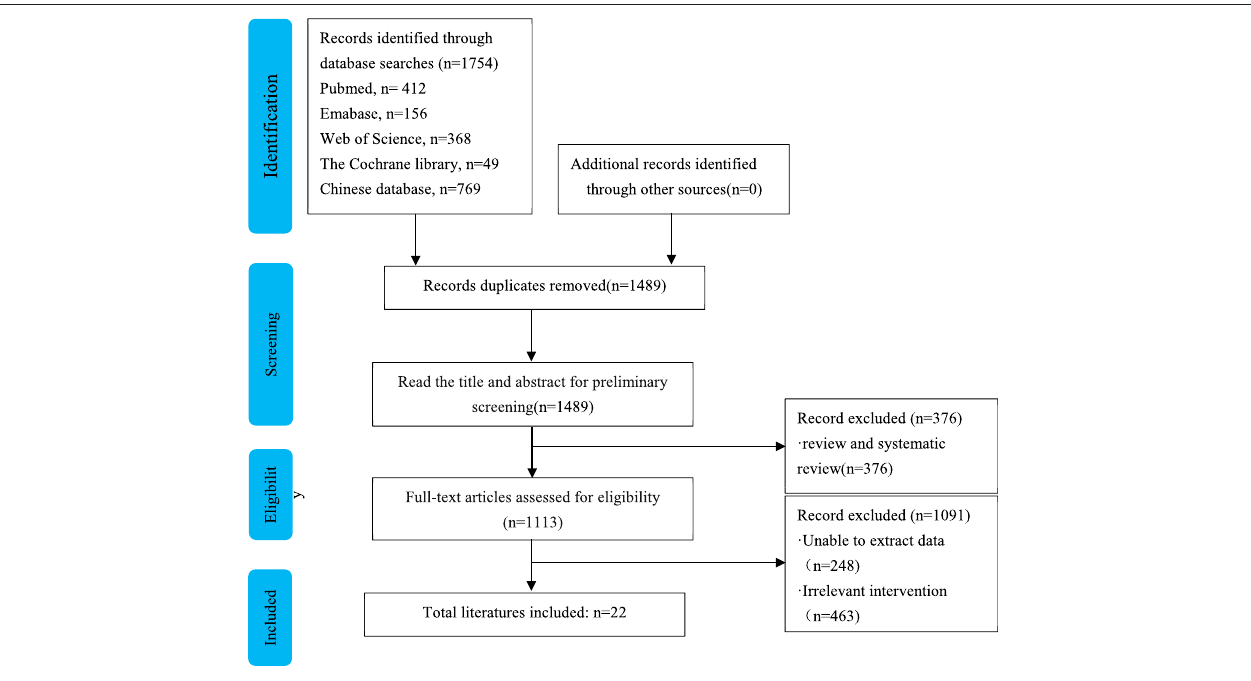
FIGURE 1 | Flow chart of literature